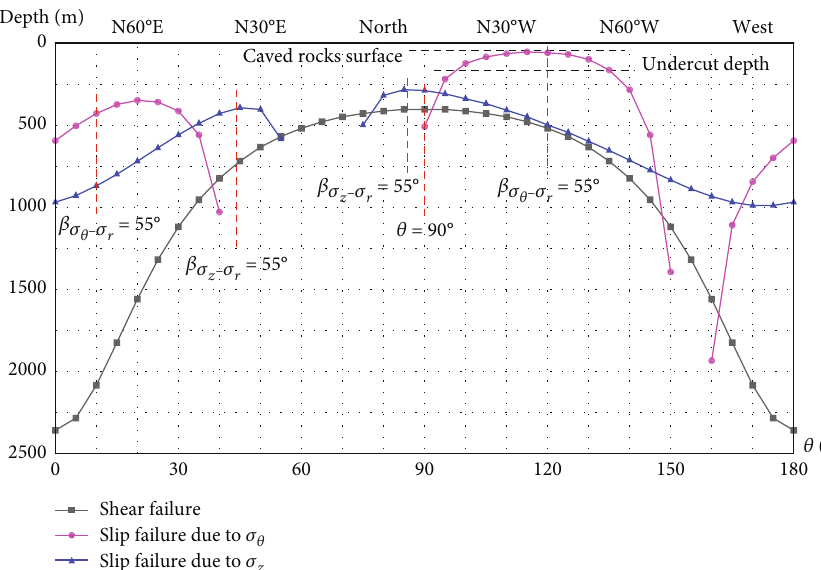
Figure 6: The variation of the critical depth of undercut around the cylindrical caved space, above which the surrounding rocks maintain stable from either rock shear failure (i.e., “ shear failure ” ), or the slip failure along discontinuities (i.e., “ slip failure due to σ θ ” or “ slip ” ). The undercut locates at the depth of 168m (i.e., “ undercut depth ” ), and the slip failure of surrounding rocks along failure due to σ z discontinuities will take place at the direction between N18 ° W and N55 ° W, as well as between S18 ° E and S55 ° E due to symmetry, because the critical depth of undercut to prevent slip failure due to σ θ (i.e., magenta line) locates above the depth of implemented undercut in these ranges of direction.